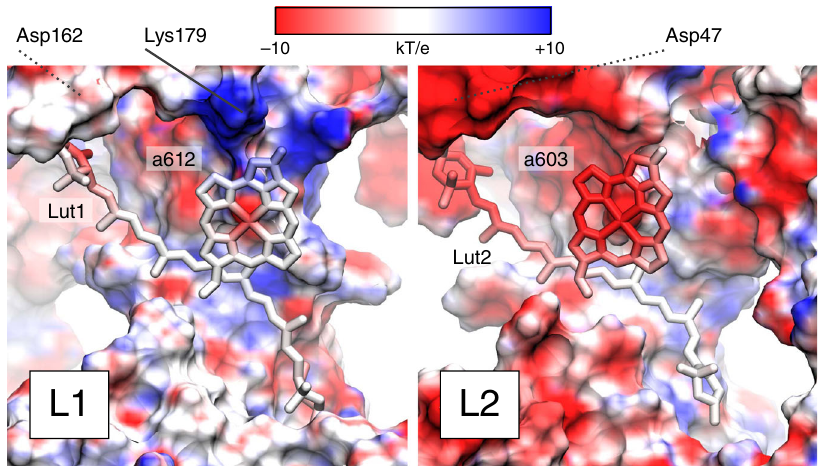
Fig. 4 Electrostatic potential around the L1 (left) and L2 (right) sites of LHCII. Only the protein surface is shown, together with the Chl – Lut dimers, both colored by electrostatic potential. The electrostatic potential was computed on one of the MD frames by using the APBS program 60 . The solid and dotted lines indicate the position of some charged residues close to the dimers on the stromal